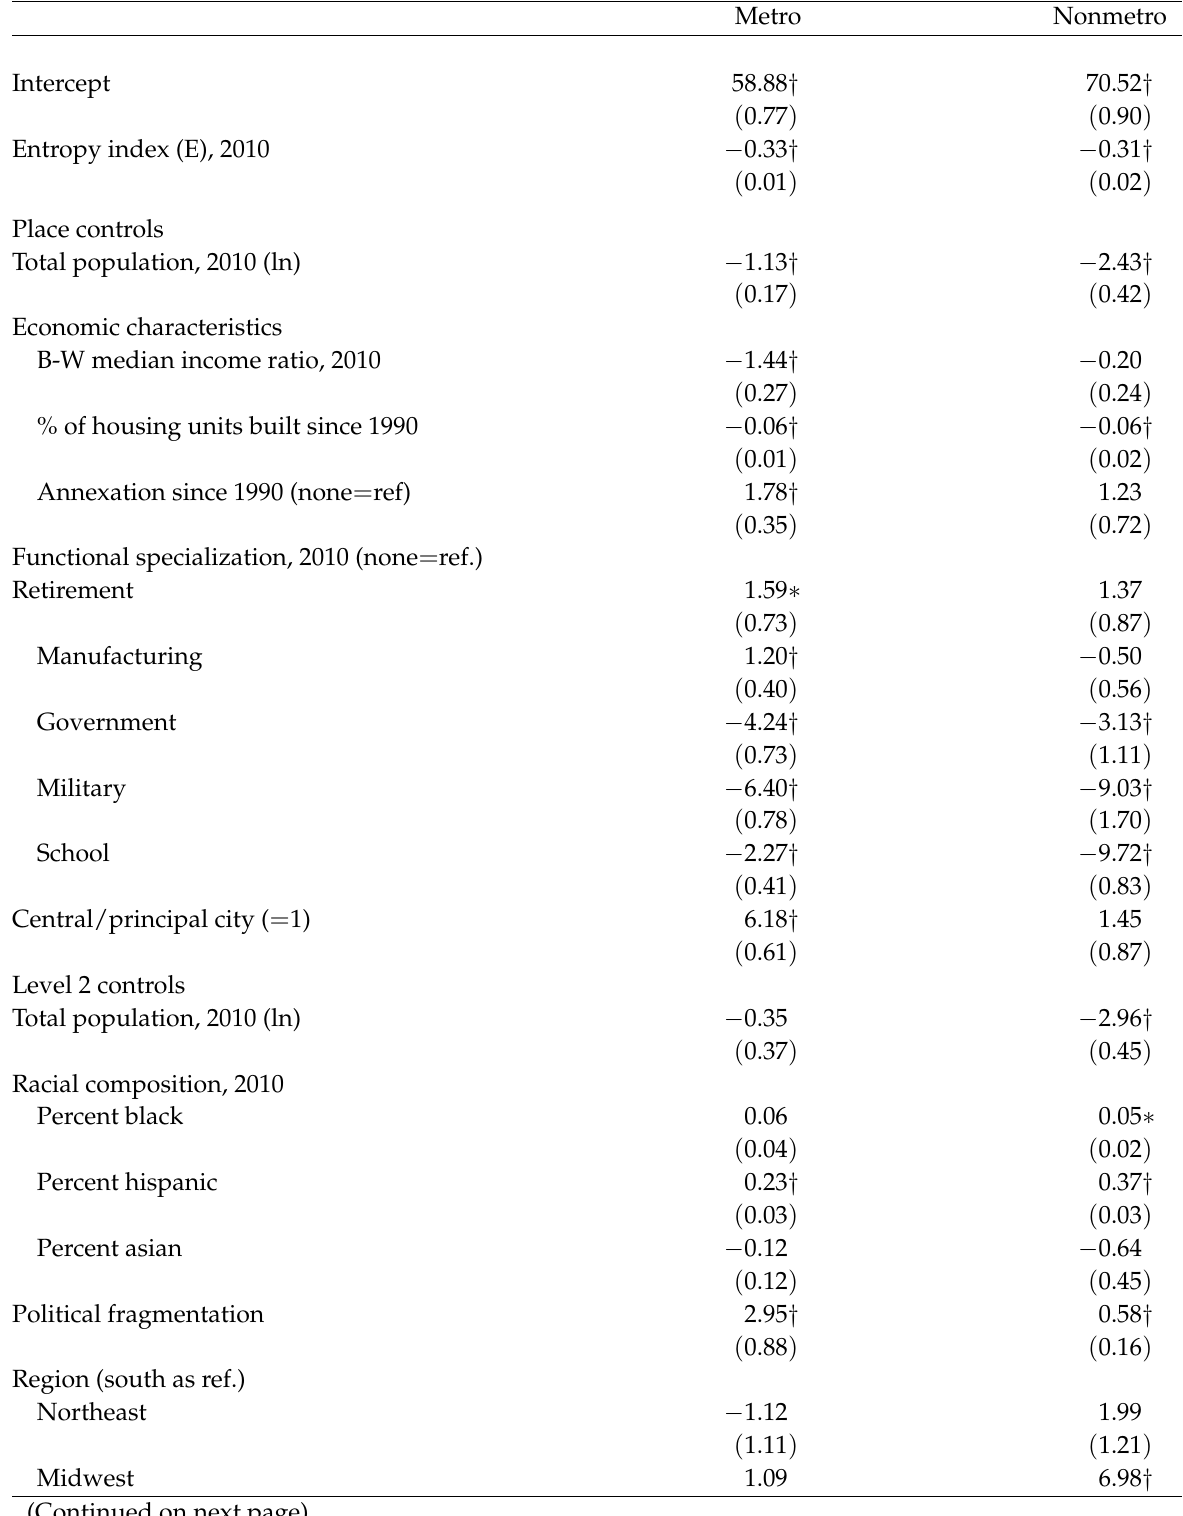
Table 6: Fixed and Random Effects from HLM Regressions of 2010 Black-White Residential Segregation on Place Entropy and Other Place and Contextual